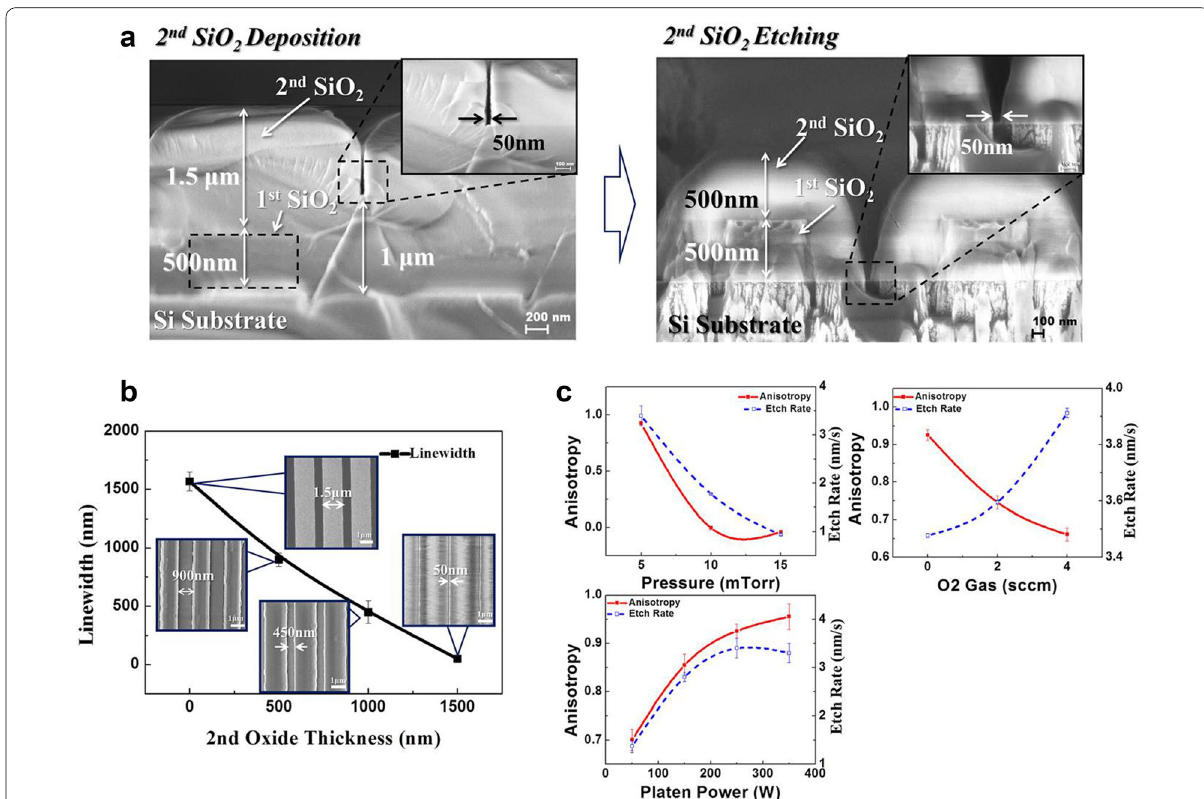
Fig. 8 The DODE nanolithography process is demonstrated. a Cross sectional SEM images of a 50 nm of grooved nanostructure prepared via the DODE lithography process; a nanopattern on a residual SiO2 layer after isotropic deposition of a second SiO2 layer (inset shows high magnifica- tion image of the nanopattern) and SiO2-based grooved nanostructure on a Si substrate after anisotropic dry etching of a second SiO2 layer (inset shows high magnification image of the nanostructure). The nanopattern was obtained through 2nd SiO2 deposition process using PECVD on lithographically patterned microstructure. Then, the residual layer under nanopattern was removed using ICP etching process to define high aspect- ratio nanostructure. b Linewidth in microstructure is reduced according to the increased thickness of the second SiO2 layer by isotropic thin film deposition process (inset shows the SEM images of the 2nd SiO2 deposited nanopatterns). The linewidth of micropatterns was gradually decreased as the increase in 2nd SiO2 thickness up to 50 nm of nanopatterns. c Investigations of the anisotropic plasma etching process in terms of the effects of pressure, oxygen gas flow rate, and platen power. Anisotropy (A) increased as decrease in pressure and O2 gas flow rate, and increase in platen power (straight and dash lines represent anisotropy and etch rate, respectively)